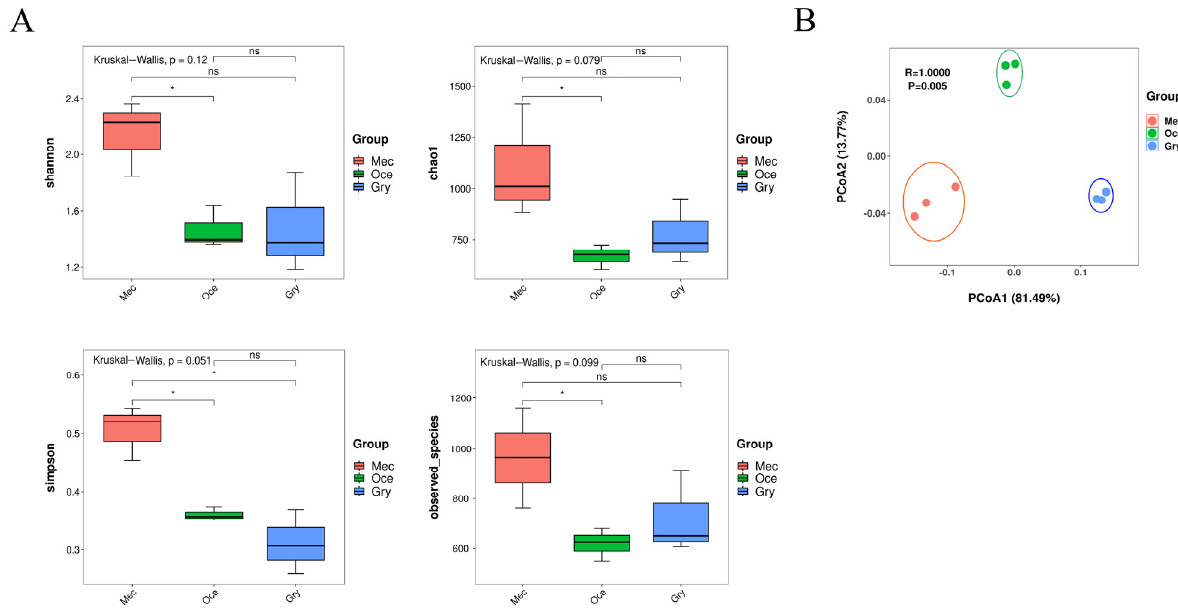
Figure 1. Gut microbiota composition of the three species. Relative abundance of gut microbial com- position, ( A ) Alpha diversity of the gut microbial community based on Shannon, Chao1, Simpson, and observed_species (ns, p > 0.05; *, p < 0.05). ( B ) Beta diversity of PCoA analysis based on Bray– Curtis distances to compare differences between species.